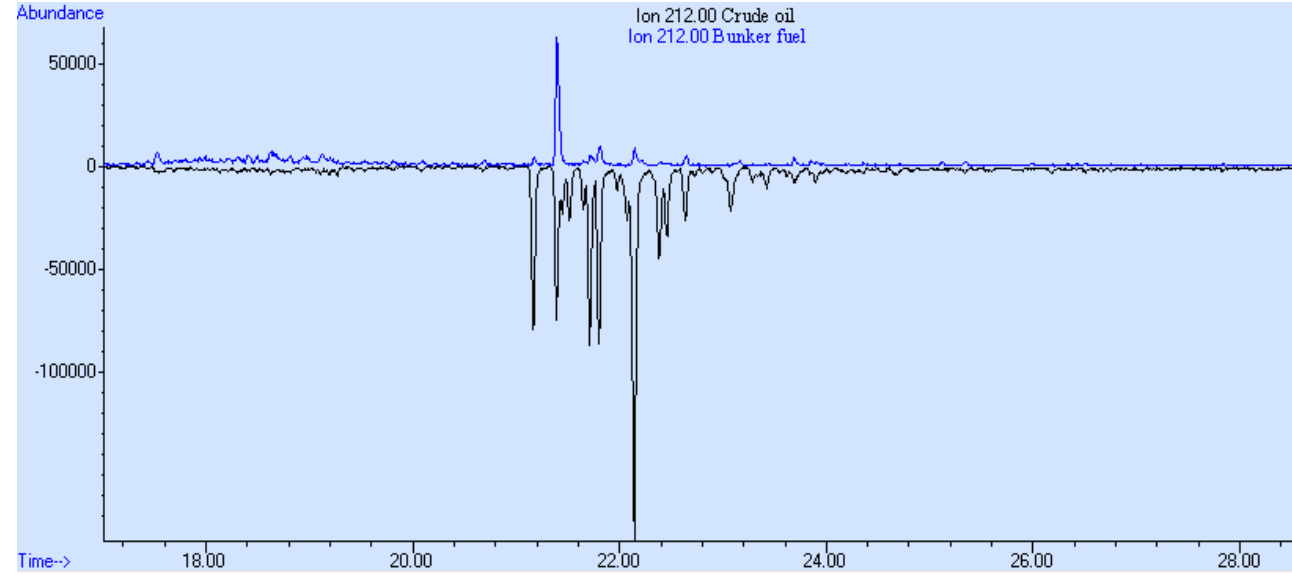
Figure 7. Comparison of EIC at m/z 198 between crude oil and bunker oil samples. Furthermore, results have shown that between crude oil and diesel samples, no correlation occurred comparing their EIC at m/z 212. In the case of the crude oil sam- ple, the abundance of DMDBT was higher enough compared to the bunker oil sample (Figure 8), while in the diesel fuel sample, the dimethyl-dibenzothiophenes were totally absent (Figure 9).